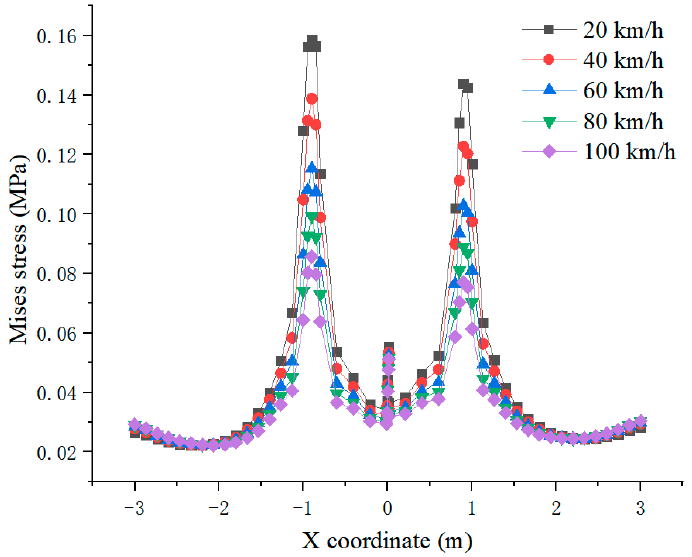
Figure 19. Distribution of Mises stress of the dam at 14.625 m under different vehicle speeds.